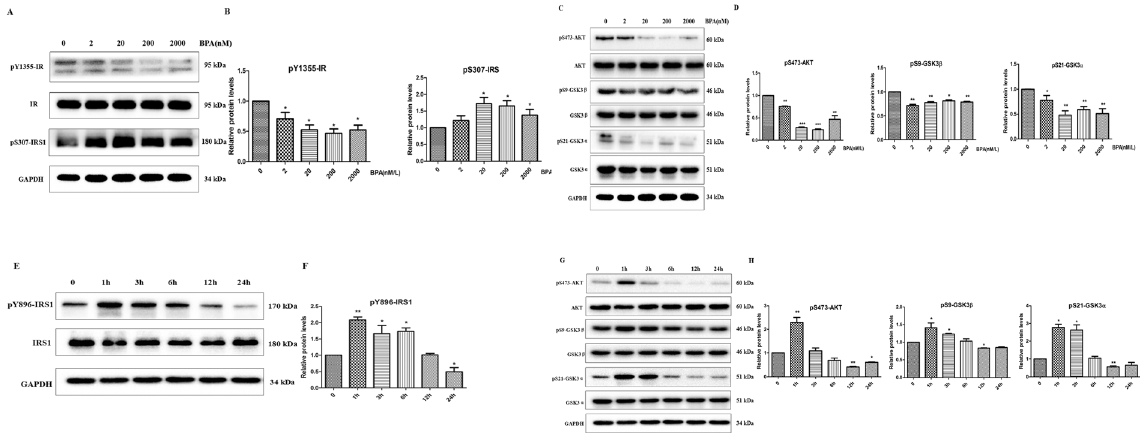
Figure 1. BPA disturbed the insulin signaling pathway. Western blot expression analysis of ( A ) different concentrations of BPA (0, 2, 20, 200, and 2000 nM/L) on IR phosphorylation and IRS phosphorylation in SY5Y cells. ( C ) Effect of different concentrations of BPA (0, 2, 20, 200, and 2000 nM/L) on AKT and GSK3 α /3 β phosphorylation in SY5Y cells. ( E ) IR phosphorylation and IRS phosphorylation in SY5Y cells at various time points (0, 1, 3, 6, 12, and 24 h) of 20 nM/L BPA treatment. ( G ) AKT, AKT phosphorylation, GSK3 α /3 β , and GSK3 α /3 β phosphorylation in SY5Y cells at various time points (0, 1, 3, 6, 12, and 24 h) of 20 nM/L BPA treatment. ( B , D , F , H ) GAPDH levels detected in parallel served as controls. Mean values ± SEMs